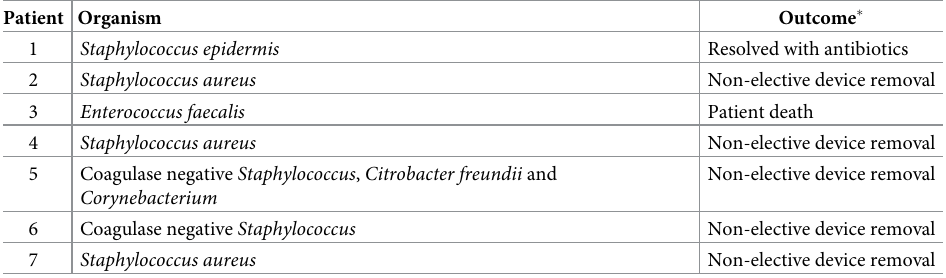
Table 2. Reported culture results and associated outcomes for patients diagnosed with CRBSIs.